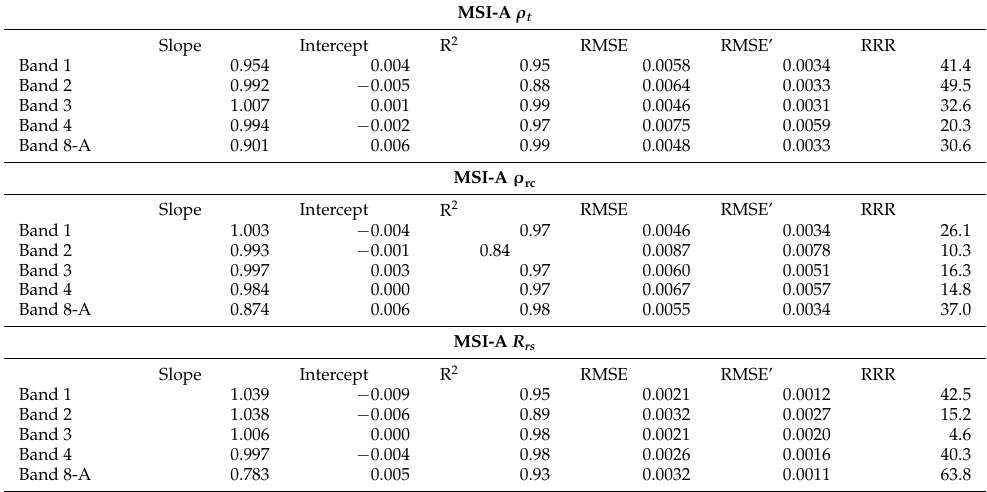
Table 6. Statistical parameters of linear regression, RMSE before and after band adjustment for test data and the RMSE reduction rate (RRR) considering the OLI and MSI-A comparison.